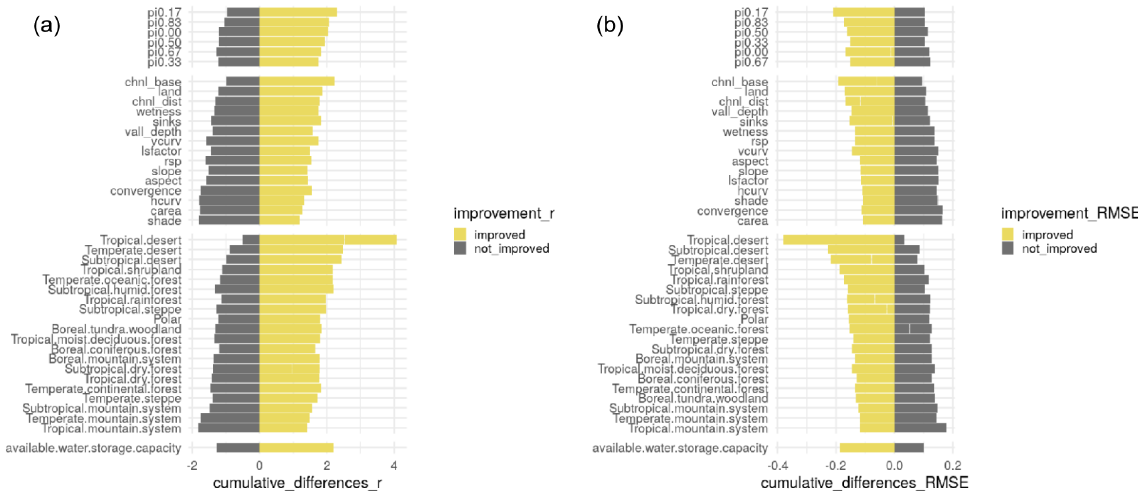
Figure 6. Impact of each factor on (a) r and (b) RMSE values across years (1991–2018). The factors with code pi0.00, pi0.17, pi0.33, pi0.50, pi0.67, and pi0.83 are the spatial coordinates rotated at multiple angles shown in Fig. A2. The rest of the factors are the digital terrain parameters used to predict the ESA-CCI annual means as they are shown in Fig. 3 and described by Guevara and Vargas (2019): aspect: terrain aspect; carea: specific catchment area; chnl base: channel network base level; chnl dist: distance to channel network; convergence: flow convergence index; hcurv: horizontal curvature; land: digital elevation model; lsfactor: length–slope factor; rsp: relative slope position; shade: analytical hillshade; sinks: smoothed elevation; slope: terrain slope; vall depth: valley depth index; vcurv: vertical curvature; and wetness: topographic wetness index. The bioclimatic features in (a) tropical, (b) subtropical, (c) temperate, or (e) boreal environments are represented by binomial variables (0–1). These variables are extracted by the Food and Agriculture Organization Global Agro-Ecological Zones project. The available water storage capacity variable is represented by continuous classes available thanks to the Regridded Harmonized World Soil